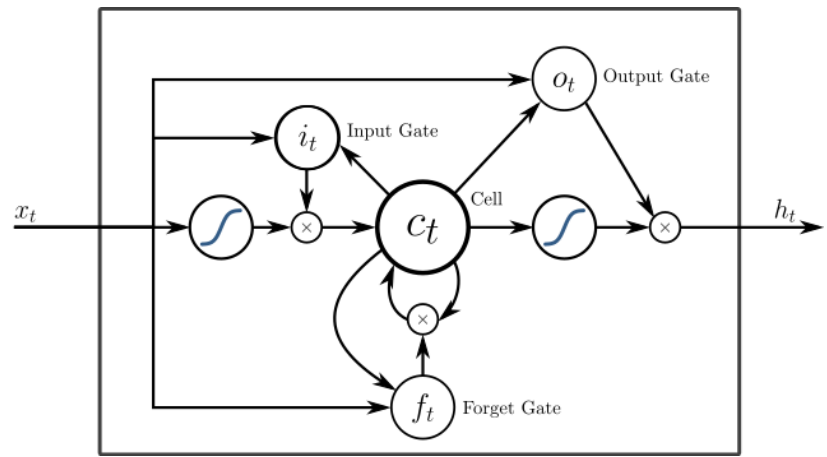
Figure 3. Scheme of the LSTM unit.